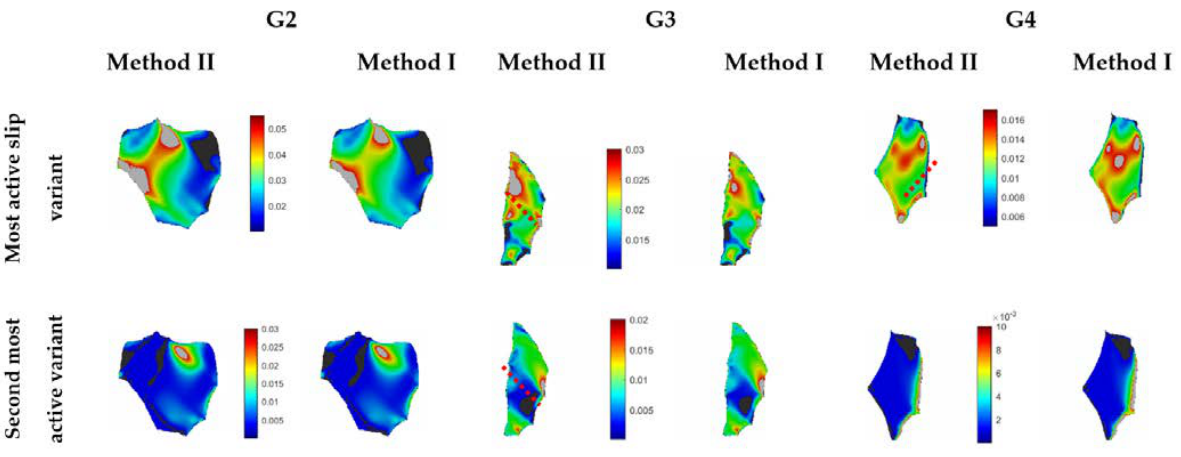
Figure 6. The distribution of resolved shear strain on the most active ( first row ) and the second most active ( second row ) slip systems. Results are for the CPFE model with Method I shown in the right column and Method II in left column. Grain IDs are shown on the top of each grain.